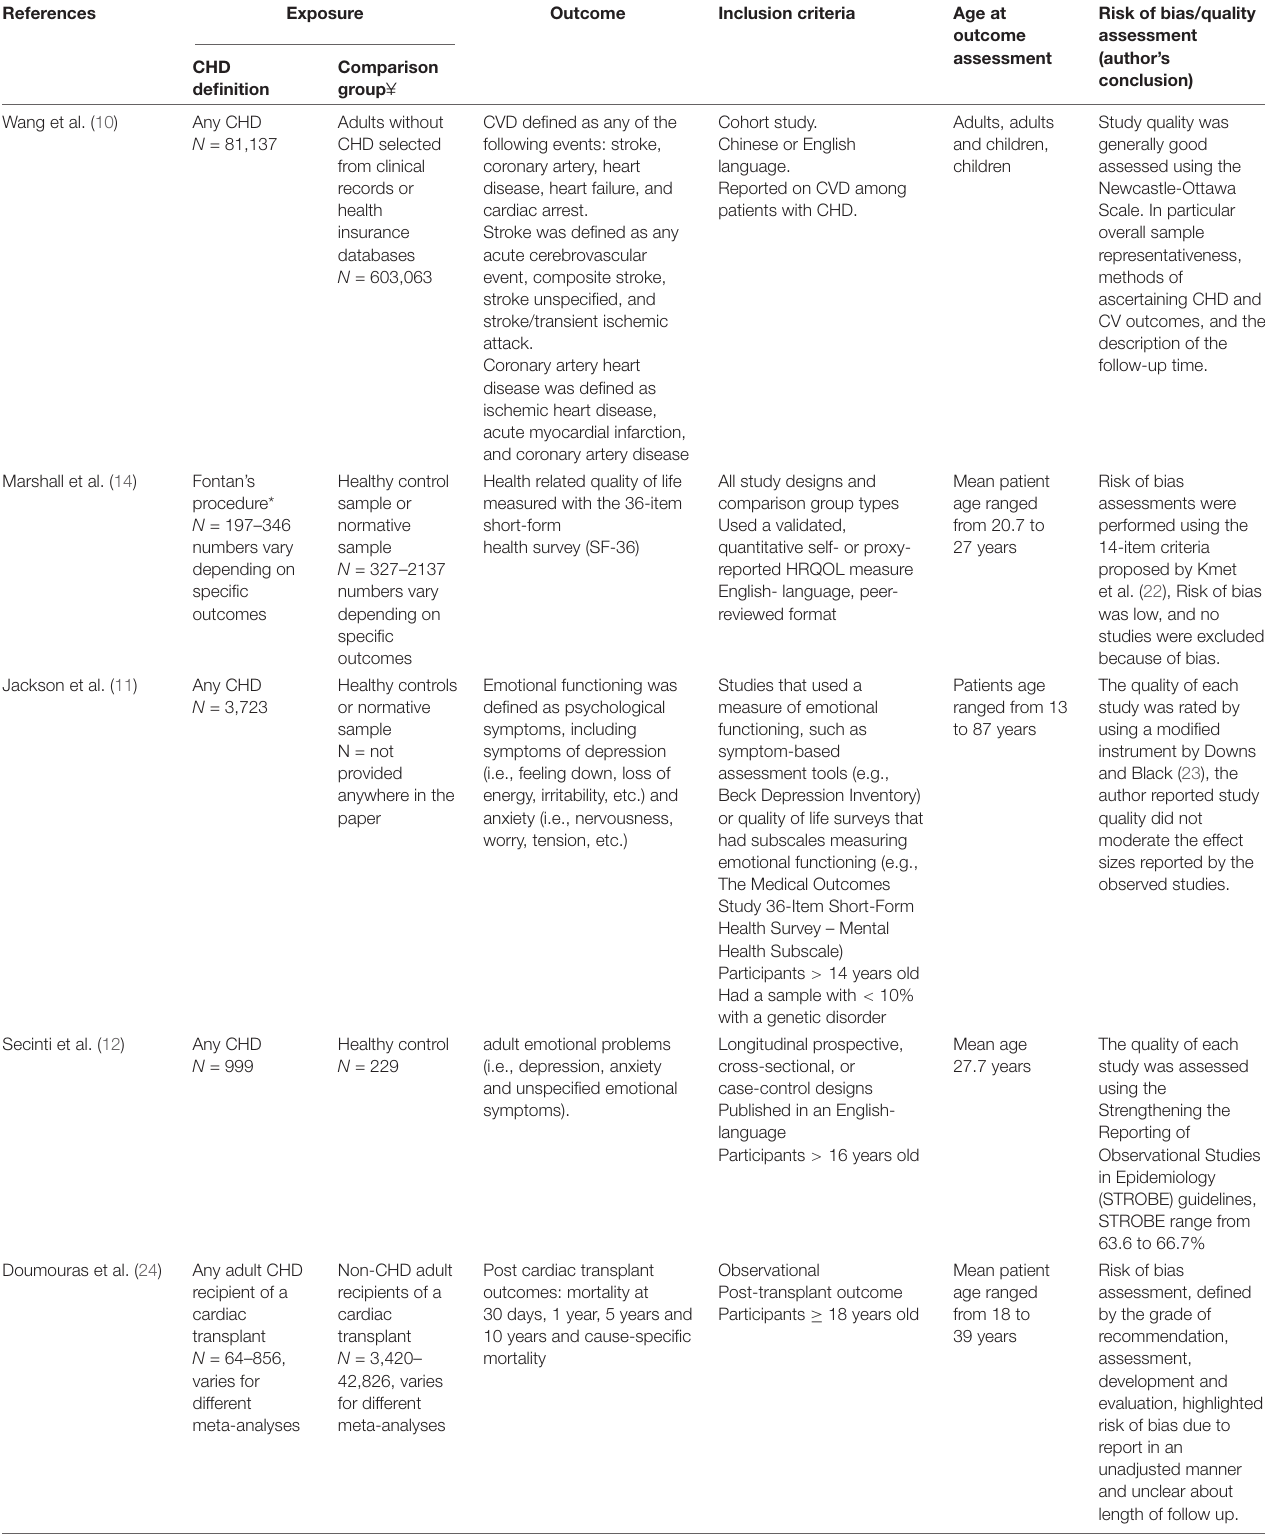
TABLE 1 | Overview of